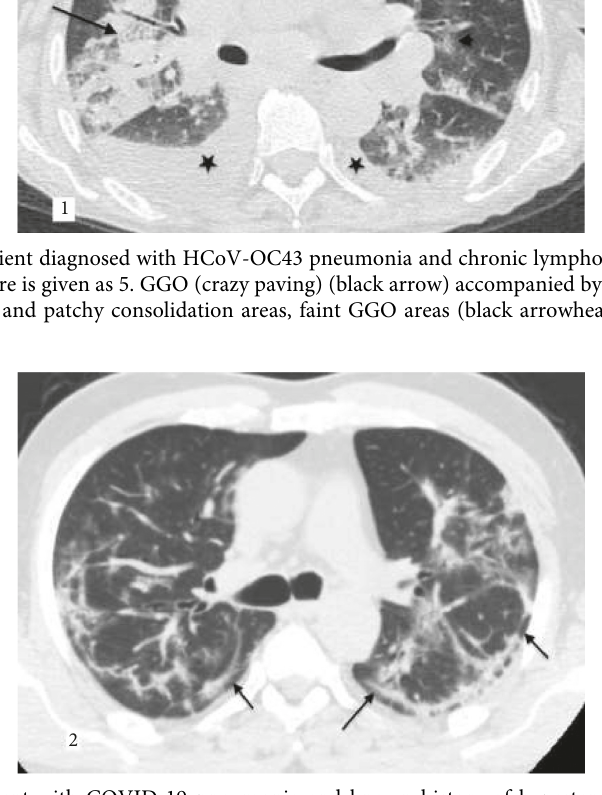
Figure 2: A 55-year-old male patient with COVID-19 pneumonia and known history of hypertension. “Typical” according to RSNA guidelines, and CORADS score given as 5. Bilateral widespread subpleural curvilinear opacities are demonstrated (black arrows).